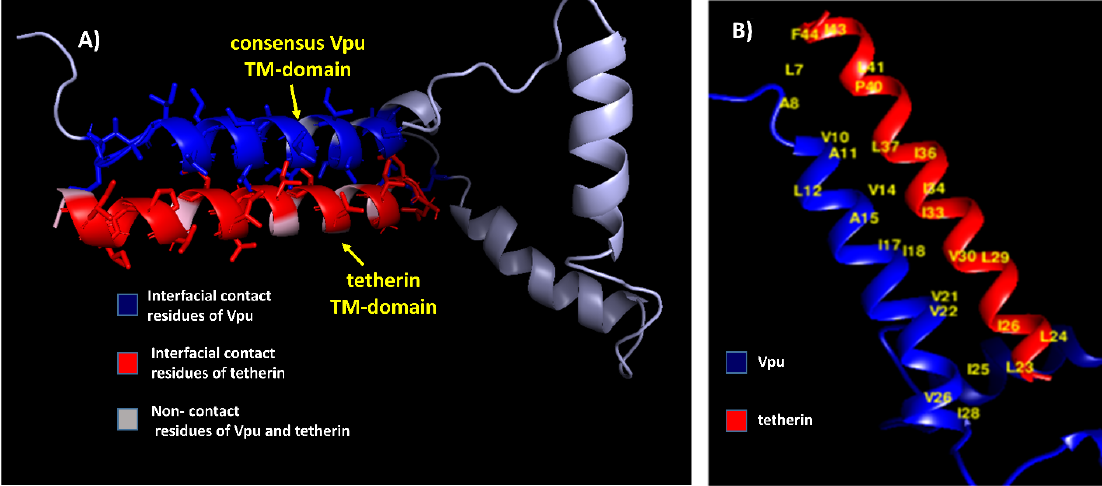
Figure 5. ( A ) Consensus Vpu–tetherin complex with interfacial contact residues of Vpu in blue, interfacial residues of tetherin red, and non-contact residues in grey. ( B ) Residues forming hydrophobic interactions (labeled in yellow) between consensus Vpu and tetherin.